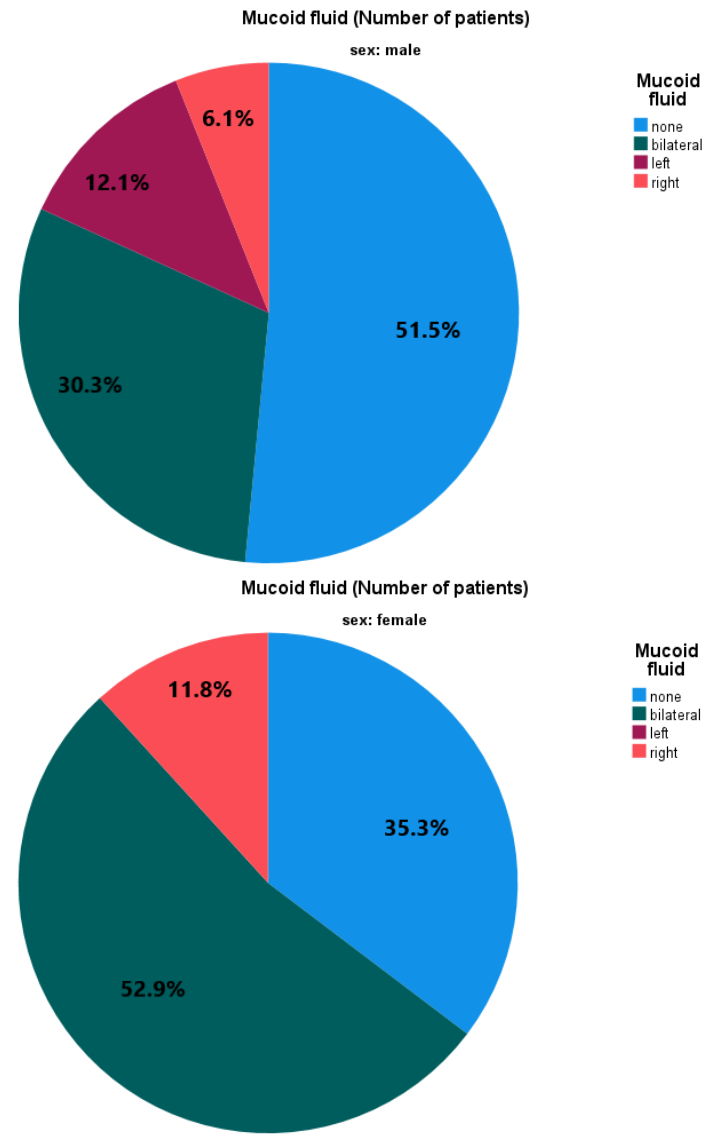
Figure 1. Absence and presence of otitis media with mucoid effusion by sex and laterality. Descriptive data of operative procedures by effusion type are shown in Table 2. A Table 2. Summary of effusion type, operative procedure, and intraoperative ABR findings (latencies in mean and standard